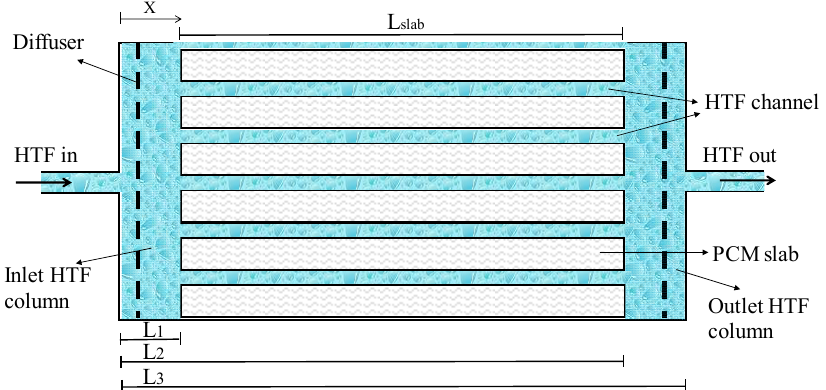
Figure 1. Scheme of the simulated PCM tank.